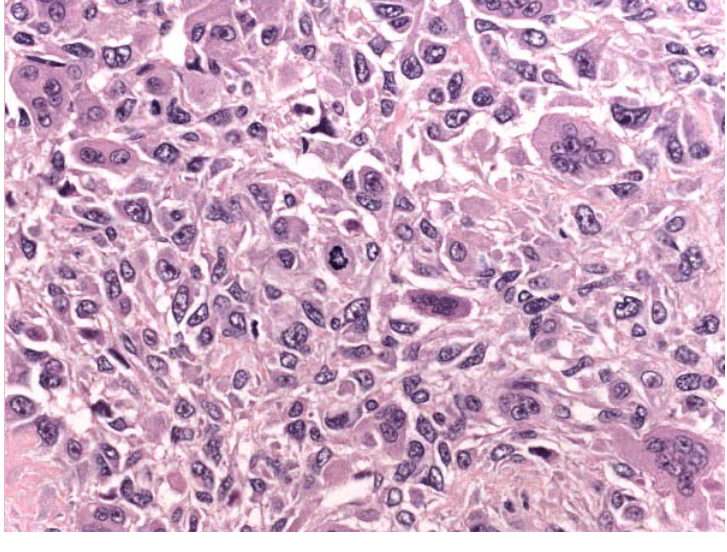
FIGURE 4 . Photomicrograph H&E ( × 400 original magnification) showing the osteoclast type giant cells and mitotic